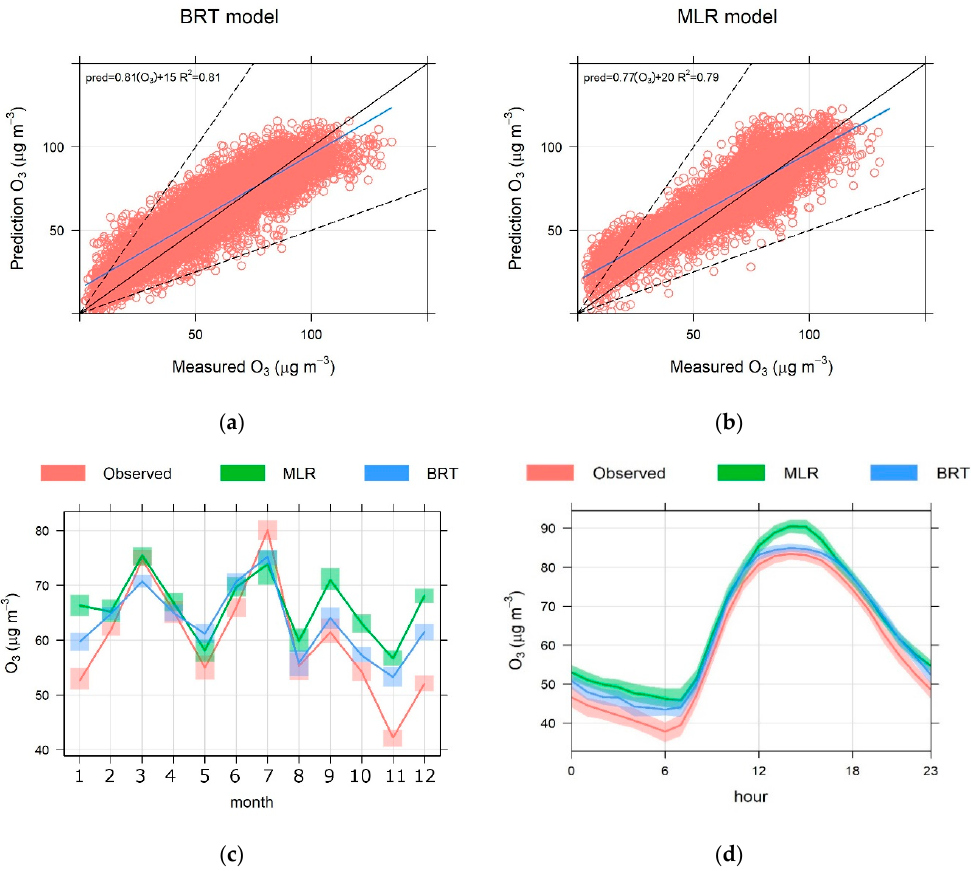
Figure 8. Predicted versus measured O 3 concentrations data obtained by BRT ( a ) and MLR ( b ) models for the validation period showing the best-fit and least square line, the equation of the line and R 2 value. A 1:1 line on the graphs facilitates the comparison to the ideal model, together with the dashed 1:2 and 2:1 lines indicating a factor of two scatter. Figures ( c ) and ( d ) show monthly and diurnal variation of observed and predicted O 3 concentrations with the 95% confidence interval in the mean.